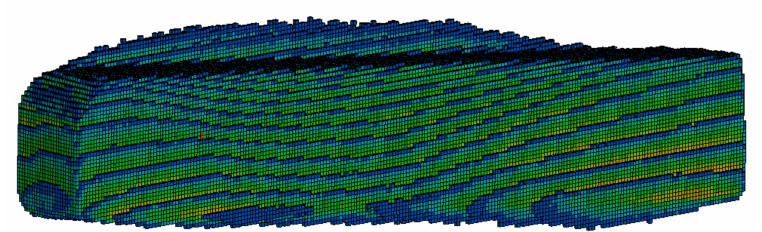
Figure 9. Unequal components of the K2F3 sample immediately after the CBCT scan.